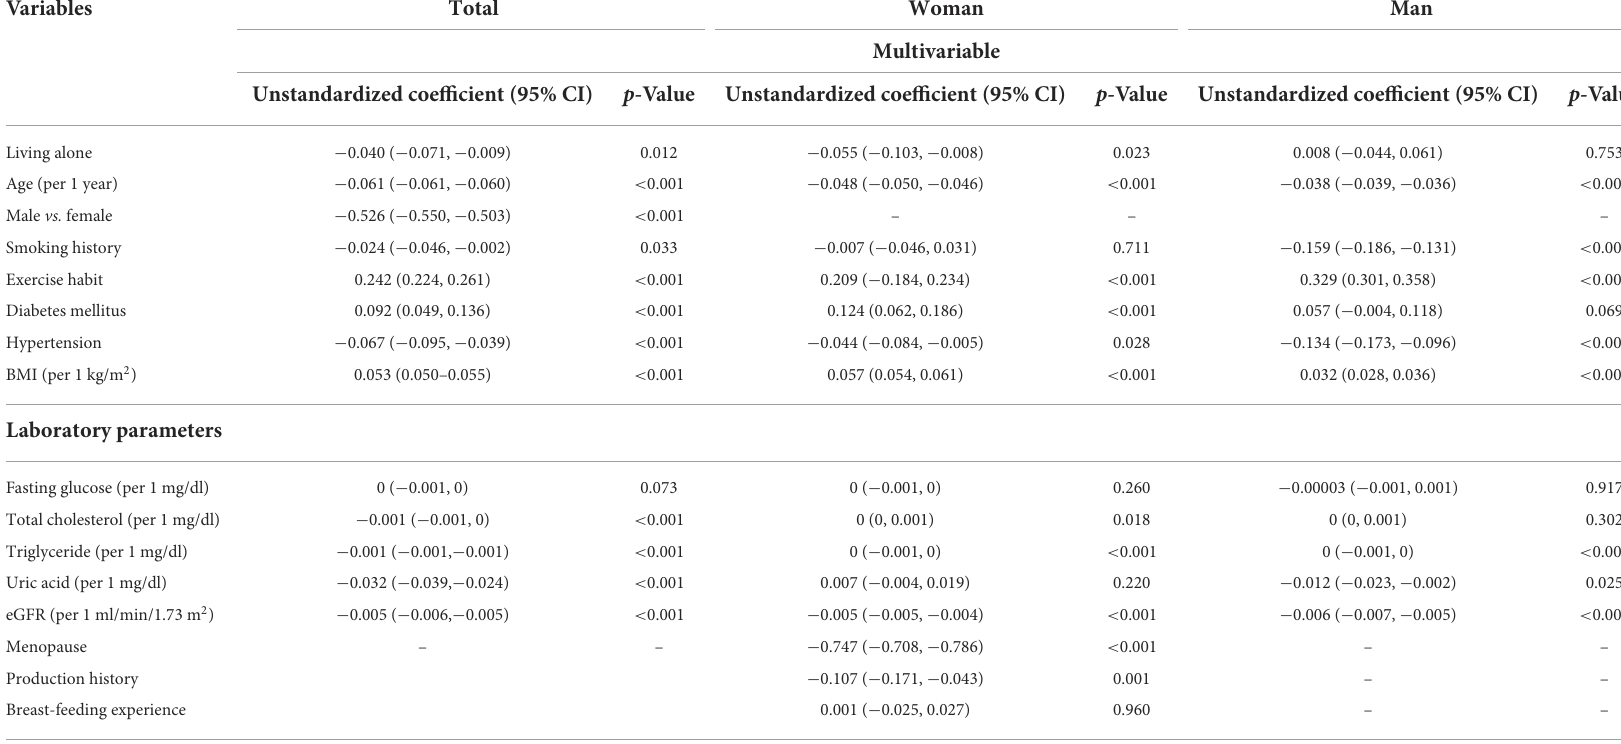
TABLE 3 Association of living condition with baseline calcaneus ultrasound T-score in all study participants ( n = 118,853) using multivariable linear regression analysis.